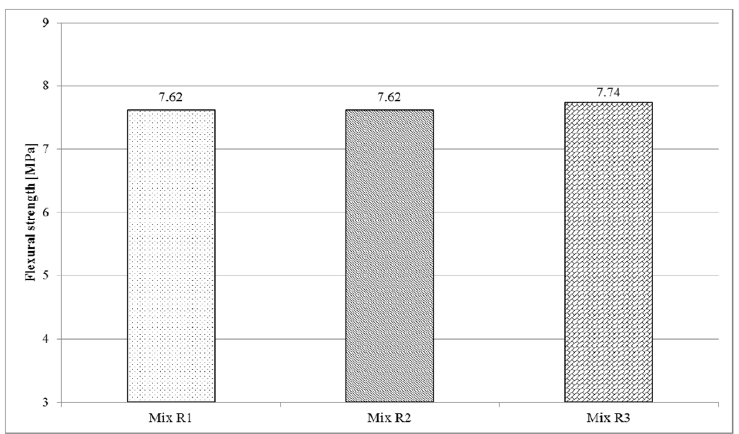
Figure 5. Flexural strengths of the test specimens after 28 days.